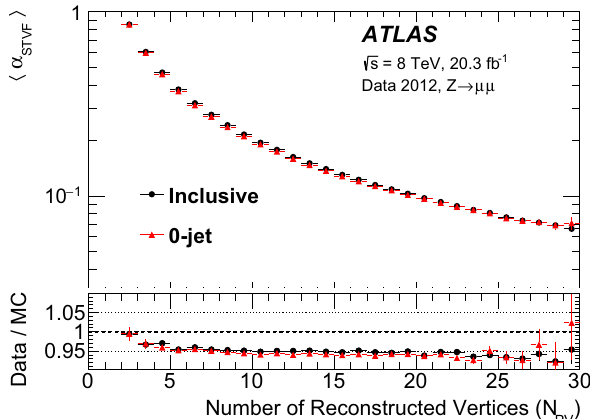
Fig. 2 The mean α STVF weight is shown versus the number of recon- structed vertices ( N PV ) for 0-jet and inclusive events in Z → μμ data. The inset at the bottom of the figure shows the ratio of the data to the MC predictions with only the statistical uncertainties on the data and MC simulation. The bin boundary always includes the lower edge and not the upper